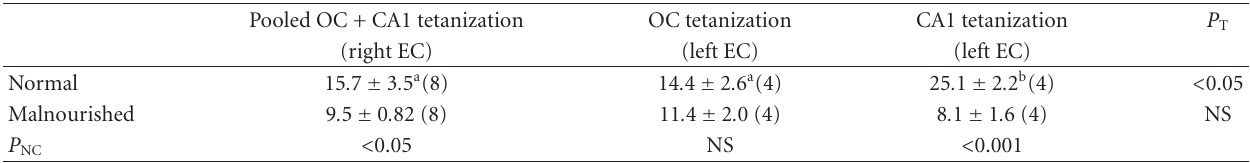
Table 2: Changes in BDNF expression (pg/mg wet tissue) in the left entorhinal cortex (EC) of 55–60-day-old normal and prenatally malnourished rats two hours after applying ipsilateral tetanizing stimulation to the occipital cortex (OC) or the CA1 hippocampal region, as compared to BDNF levels in the right EC. Values are means ± SEM. The number of samples in each group is shown in parentheses. BDNF concentrations in right EC samples after tetanizing the left OC or left CA1 did not significantly di ff er between them, and were therefore pooled. Comparisons of BDNF levels between normal and malnourished groups were made using unpaired Student’s t -test, and P NC is the probability level for comparisons related to the nutritional condition (NS = not significant). Comparisons between basal BDNF levels (right EC) with those obtained after OC or CA1 tetanization (left EC) were made using nonparametric ANOVA (Kruskal-Wallis test) followed by Dunn’s multiple comparisons post-hoc test, and P T is the probability level for comparisons between right and left EC samples (di ff erent superscripts indicate a significant di ff erence, P < . 05; NS = not significant). Pooled OC + CA1 tetanization OC